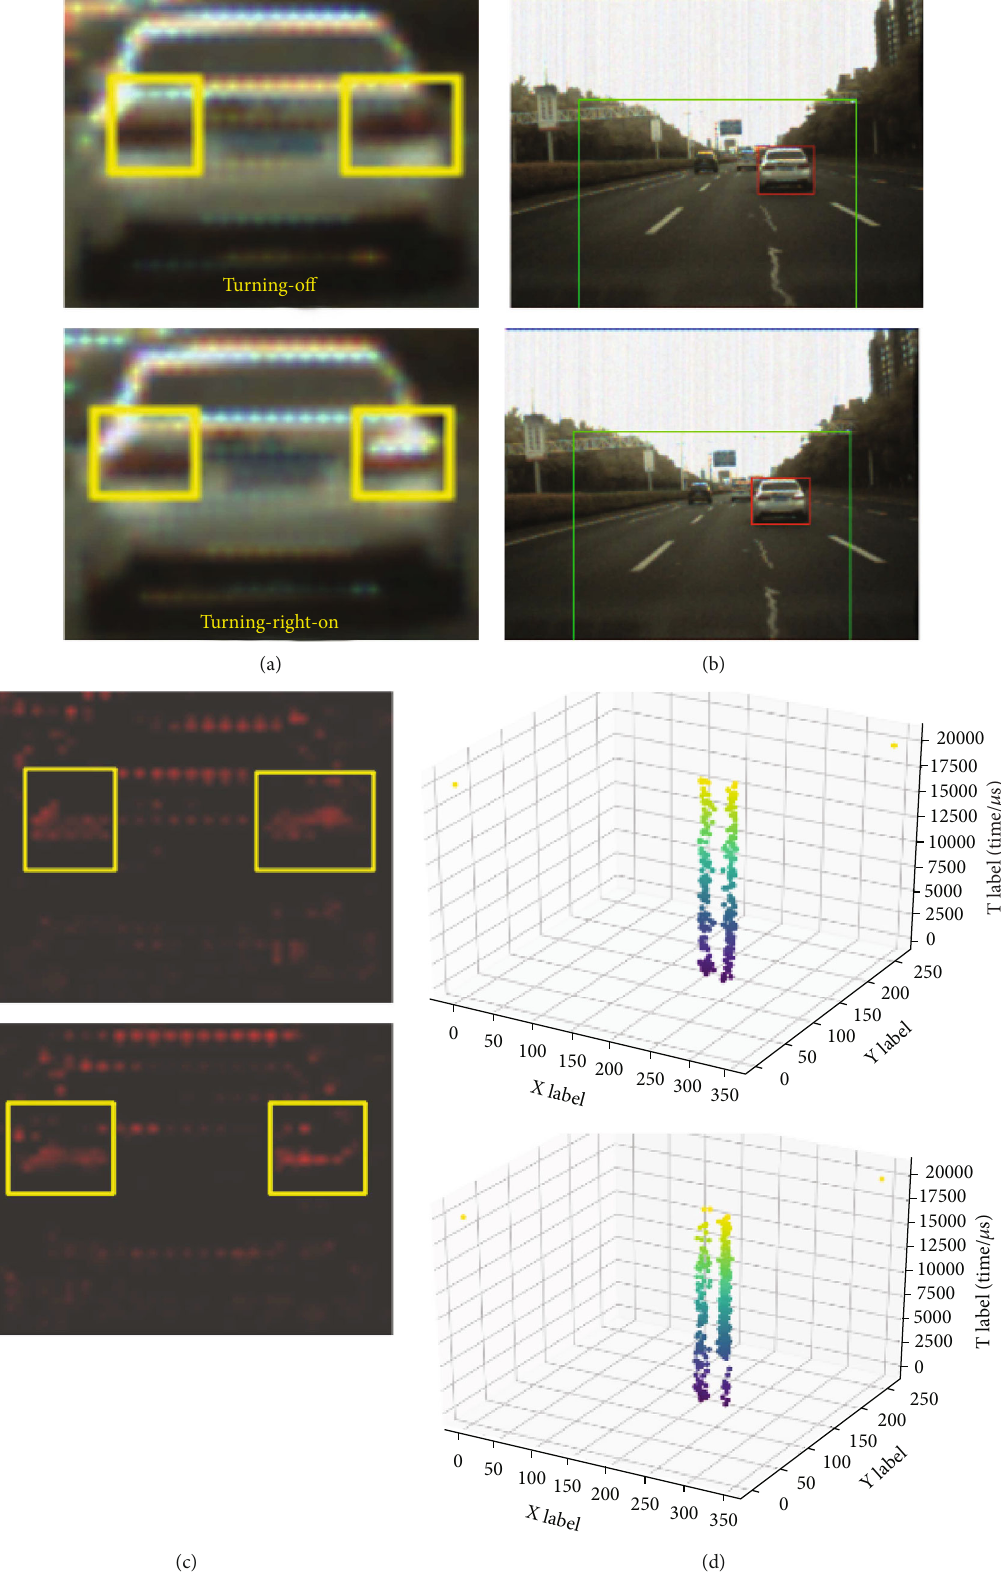
Figure 12: Measurement results from a preceding vehicle. The preceding vehicle switches its taillight state from turning-o ff state (the top row) to turning-right-on (the bottom row). (a) Measurement results. (b) The preceding vehicle detected. (c) The position of the vehicle ’ s taillights located. (d) DVS events for each taillight